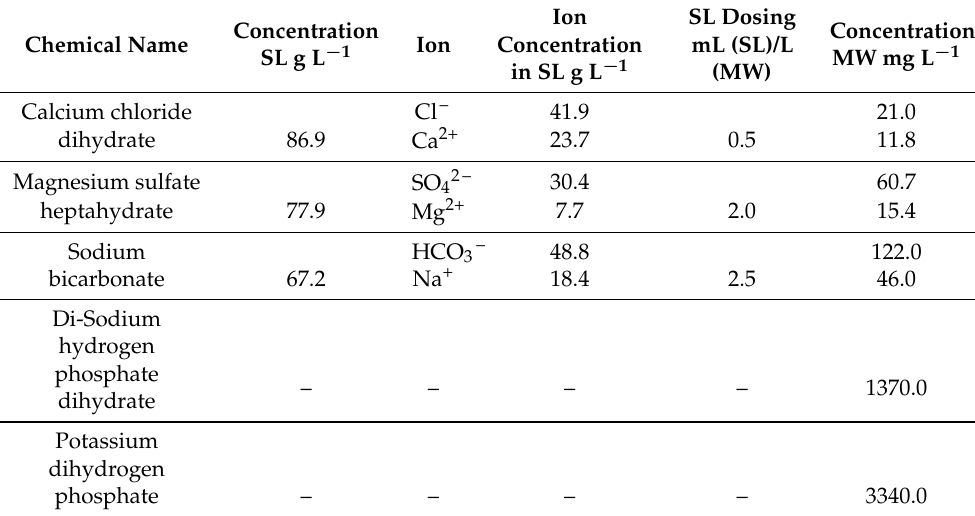
Table 7. D. Test water for pH value low—Experiment no.4.